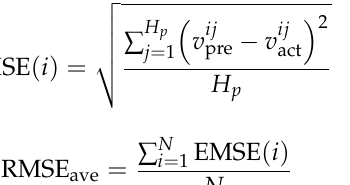
Table 3. RMSE of different predicted lengths.